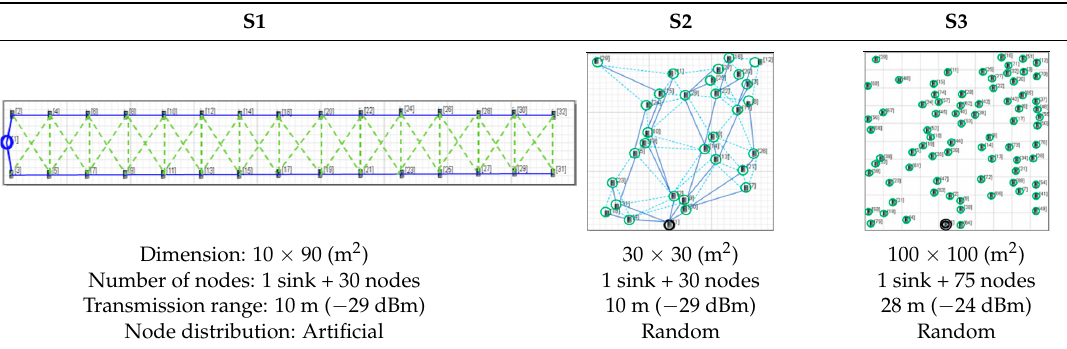
Table 4. Three static network scenarios and parameter values.